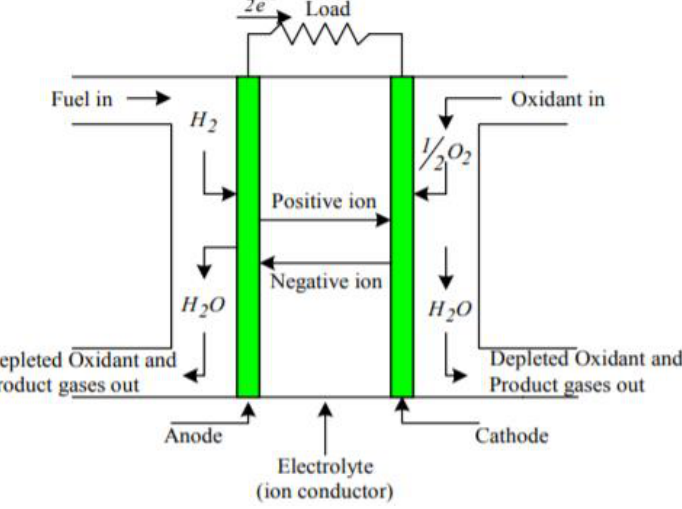
Figure 2. Fuel cell operation diagram [38].